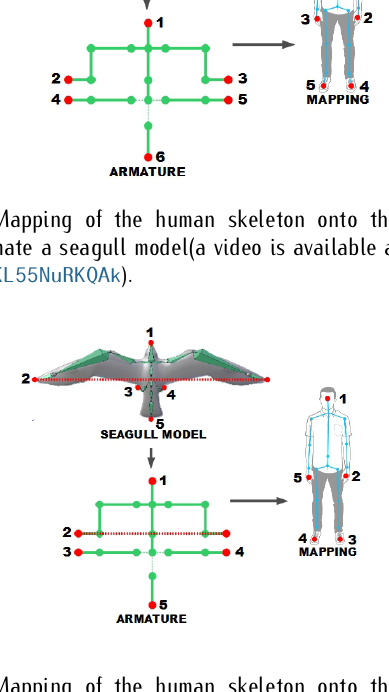
Figure 8. Mapping of the human skeleton onto the armature used to animate a seagull model with master bone controlling two end-effectors (a video is available at http://youtu.be/ qaqP3za2dJM ).